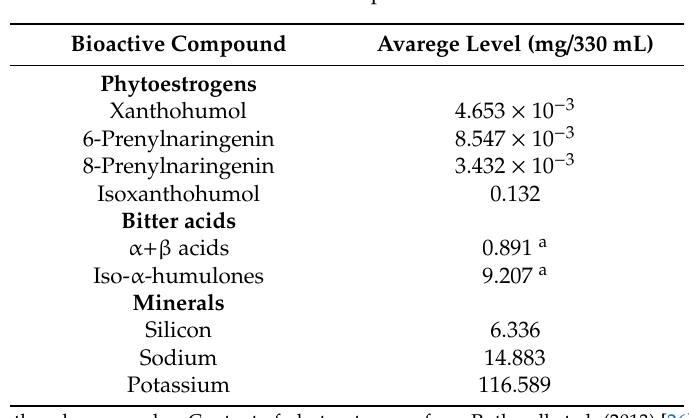
Table 1. Mean content of selected bioactive compounds in a standard drink of regular